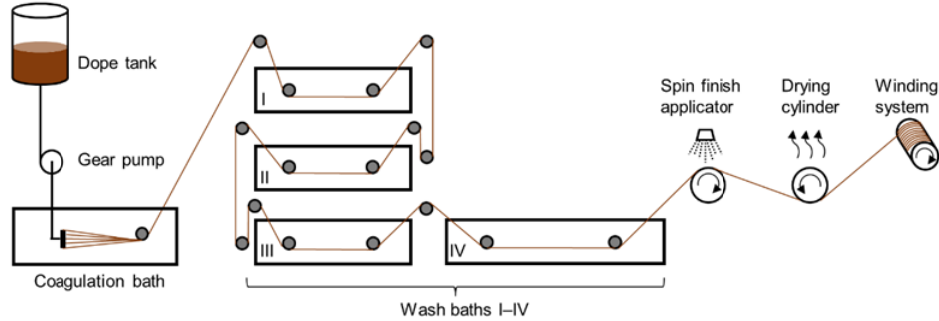
Figure 1. Schematic of the wet spinning equipment used for precursor spinning.